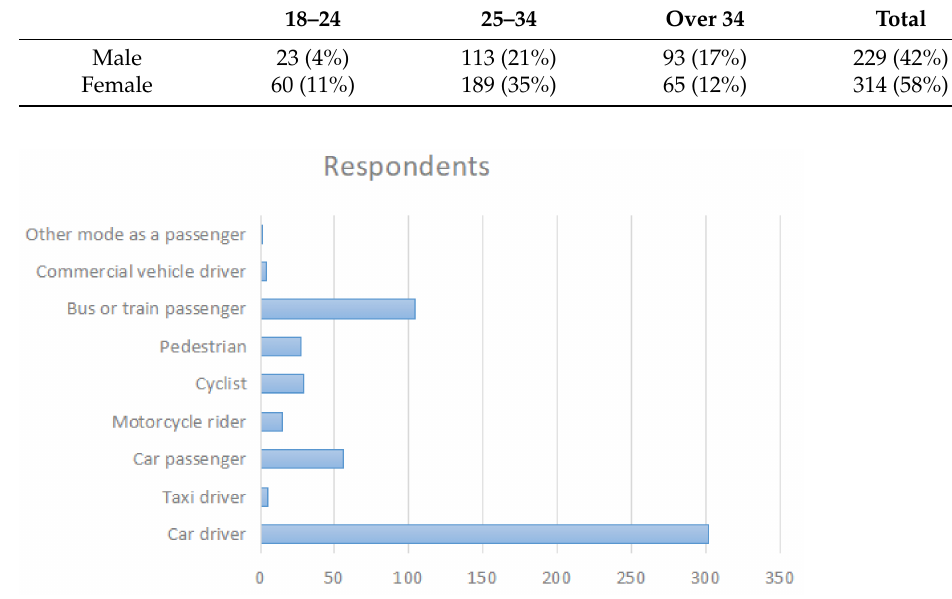
Figure 1. Participants’ most commonly used transport